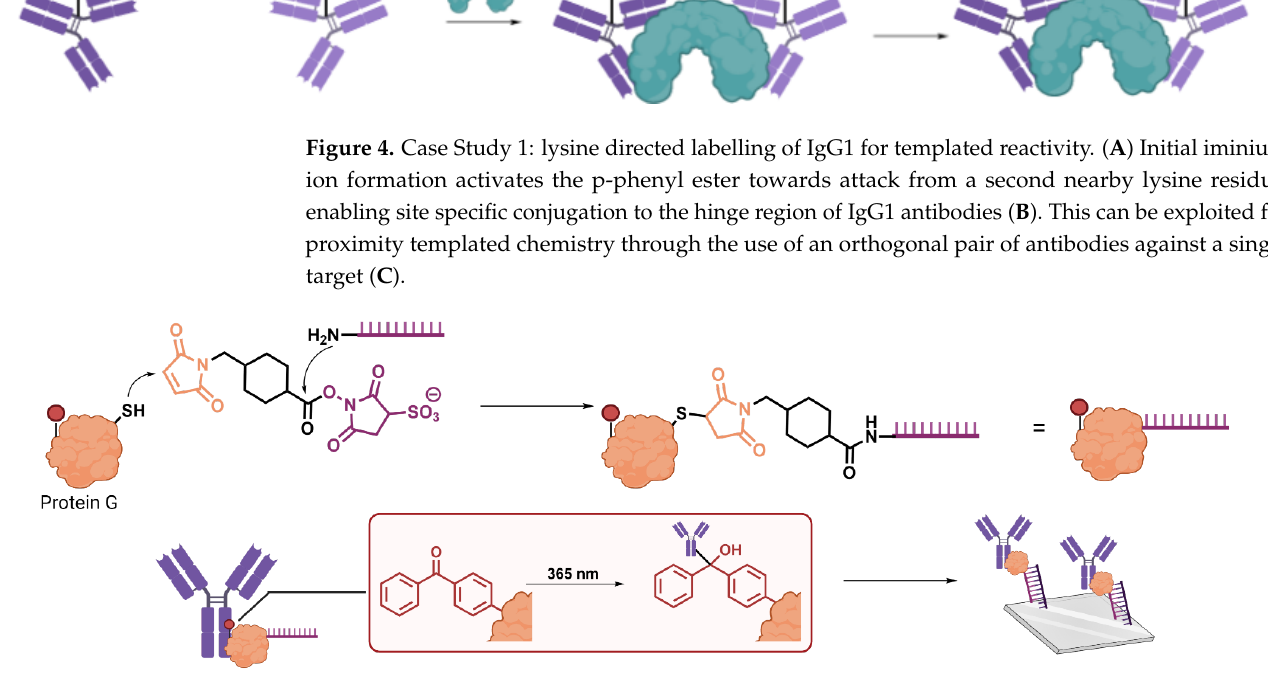
Figure 5. Case Study 2: engineered Protein G-oligonucleotide conjugates as generic handles for labelling antibodies and Fc-fusion proteins. A bifunctional linker is used to conjugate oligonucleotides to a mutant Protein G containing a single cysteine residue. The specificity of Protein G for the Fc domain of antibodies is then harnessed to facilitate site specific conjugation through a BPA residue (represented as a red circle).